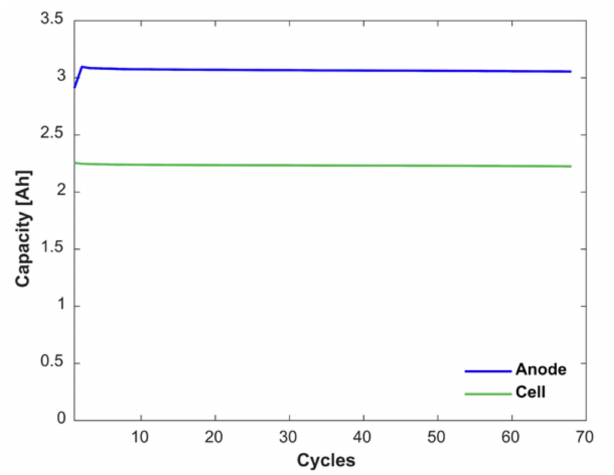
Figure 11. Comparison between anode (blue) and cell capacity (light